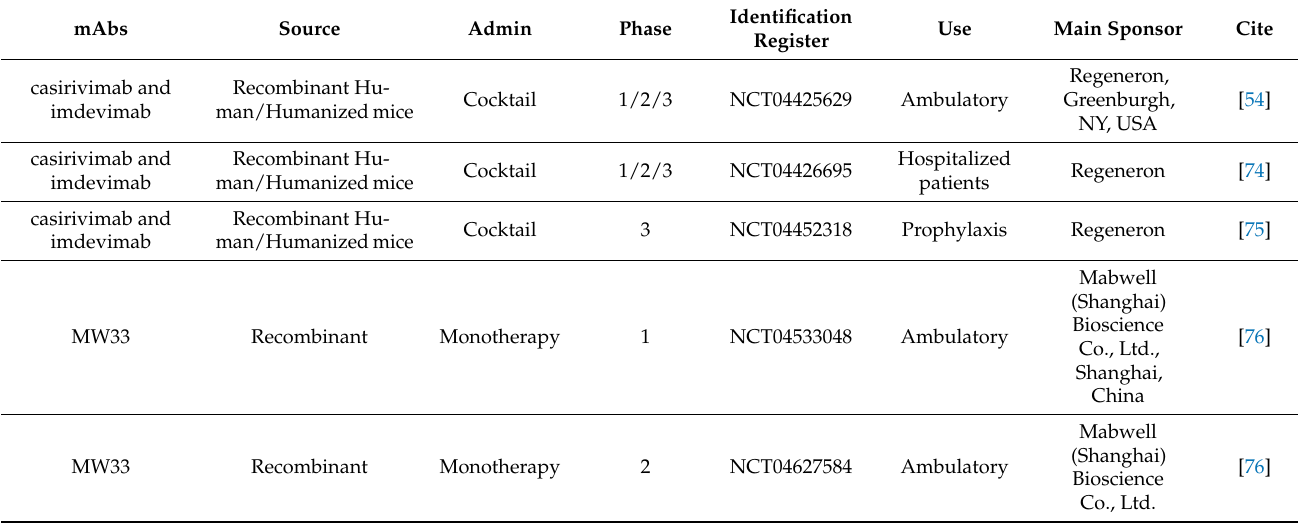
Table 1. Anti-Spike mAbs tested in clinical